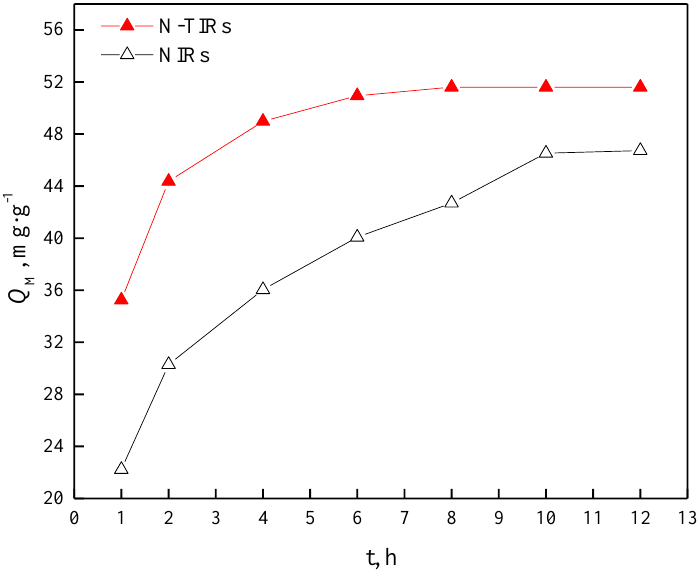
Figure 8. Effects of contacting time on the adsorption capacity of the N-TIRs and NIRs for V(V).